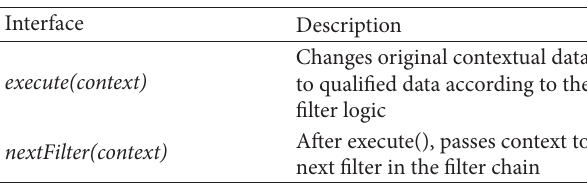
Table 1: Filter interface.